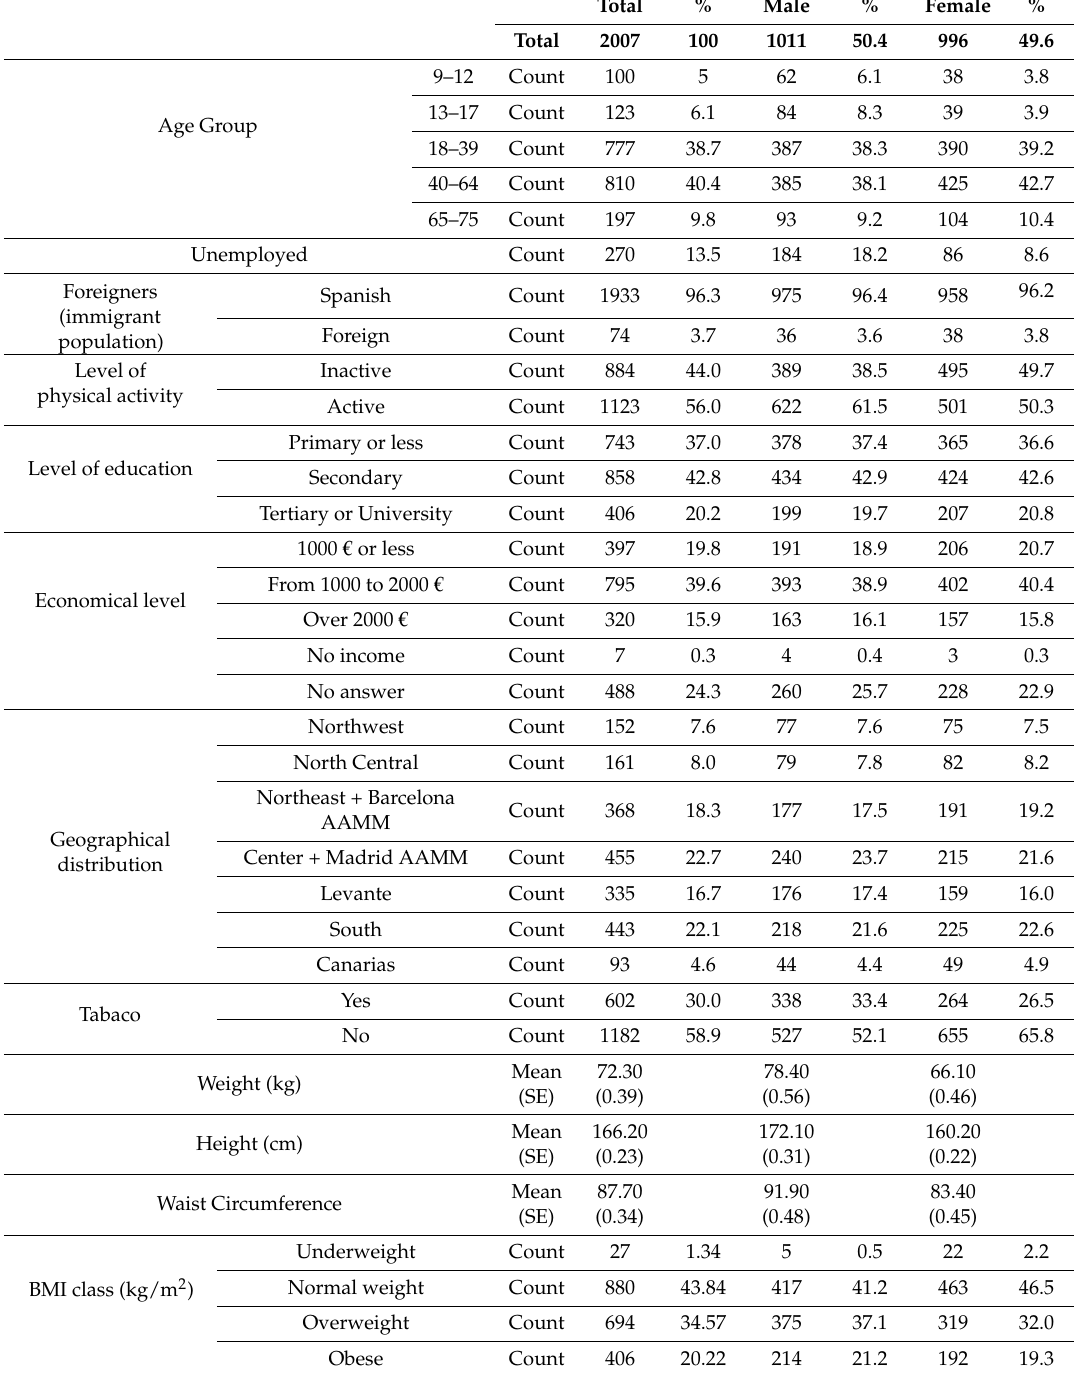
Table 1. Statistical description of the sample